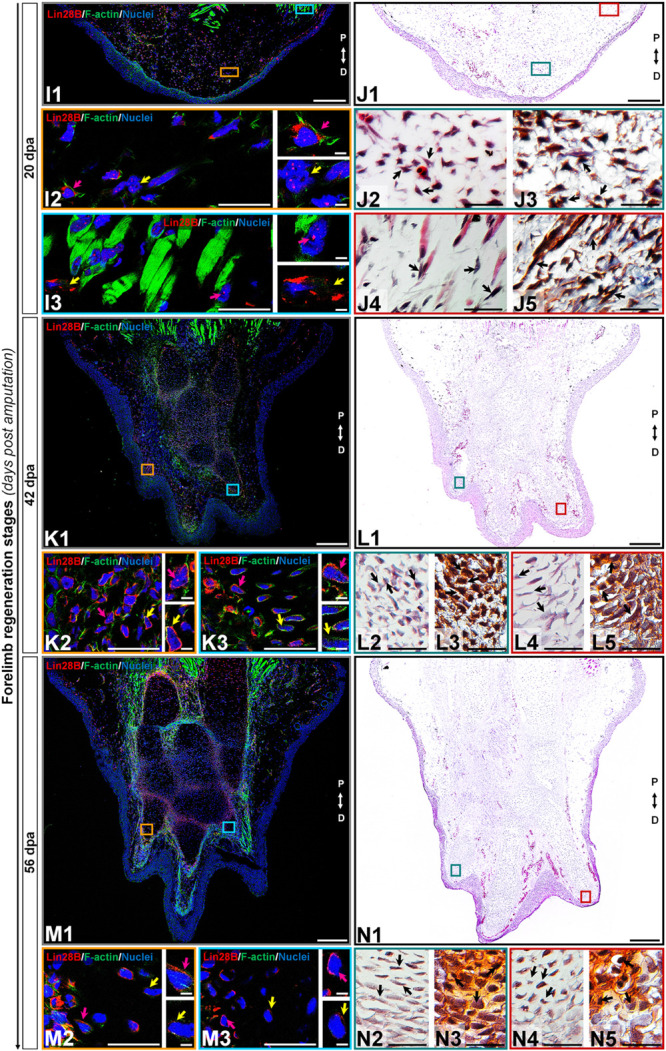
Subcellular immunolocalization of amxLin28B during forelimb regeneration (continuation). (I–N) Histological sections of representative stages during the limb regeneration oriented in the Proximal-Distal axis. (I,J) Medium blastema stage (20 dpa). (K,L) Late palette–early digits stage (42 dpa). (M,N) Late digits–growth stage (56 dpa). (I1,K1,M1) Intracellular localization dynamics of amxLin28B marked in red, by contrast with DAPI (blue) and Phalloidin (green) that delimit nuclei and cell shapes, respectively. Scale bars: 500 μm. (I2-3,K2-3,M2-3) Magnifications with different color contours to remark some areas of interest for amxLin28B in red, DAPI in blue, and Phalloidin in green; arrows in yellow and magenta have in turn their own zoom in. Scale bars: 50 and 5 μm, respectively. (J1,L1,N1) The architectural organization of tissues is shown with Hematoxylin and Eosin staining. Scale bars: 500 μm. (J2/4,L2/4,N2/4) Magnifications with distinct color contours to indicate some areas of interest in Hematoxylin and Eosin staining. Scale bars: 50 μm. (J3/5,L3/5,N3/5) Histological changes detected on extracellular matrix for similar zones indicated in H&E ampliations, which are displayed with a differential staining to connective tissue. Scale bars: 50 μm. The different arrows indicate diverse tissue components, as described in results.